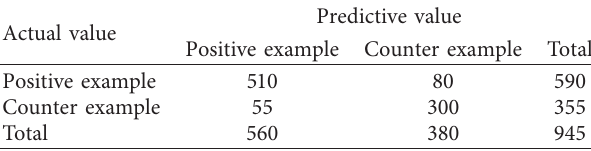
Table 1: Confusion matrix of DS classification results.